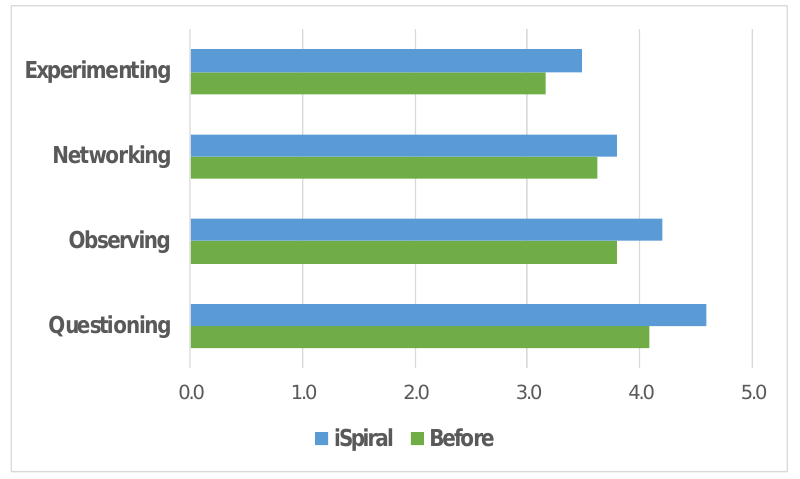
Fig. 4. Participants responses after implementing iSpiral